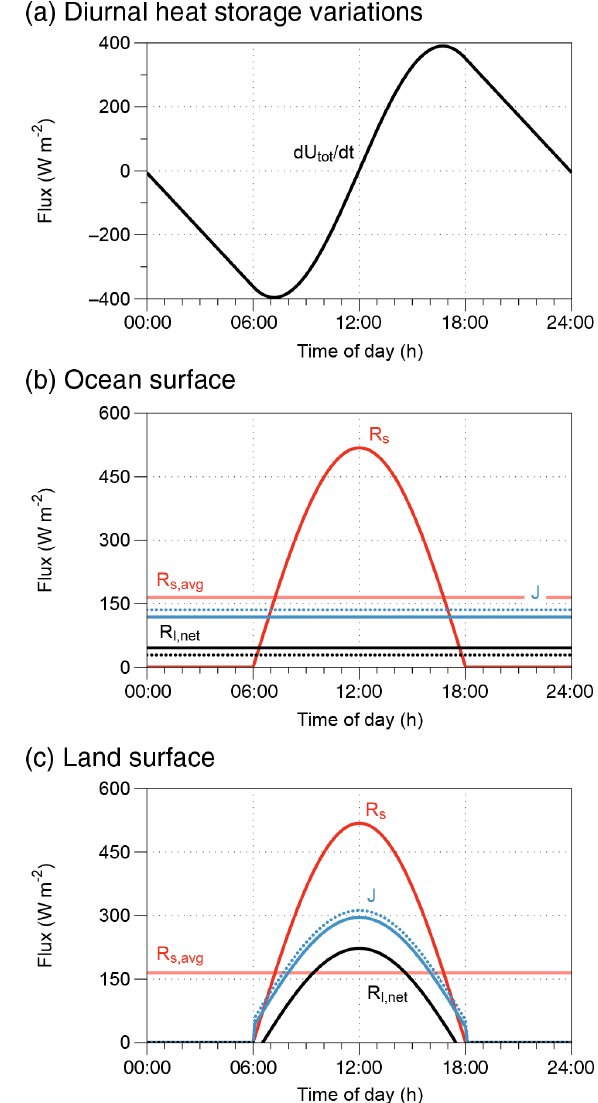
Figure 4. Mean diurnal heat storage variations inferred from the solar forcing (a) and the associated diurnal variations in surface en- ergy balance partitioning of (b) an ocean surface and (c) a land sur- face as predicted by the approach described here. The pale red line in panels (b) and (c) refers to the average of absorbed solar radiation at the surface of R s , avg = 165Wm − 2 . The dotted lines in panels (b) and (c) refer to the respective values for a global mean warming of (cid:49)T s = 5K due to changes in greenhouse forcing.